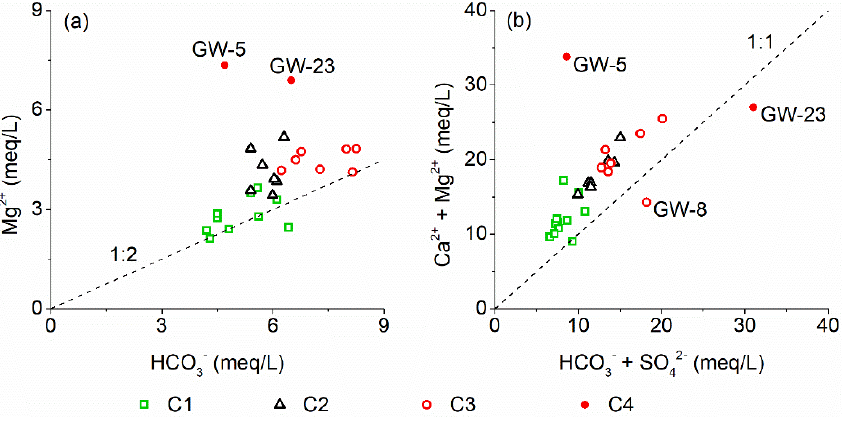
Figure 6. Relationship between Mg 2+ and HCO 3 − , Ca 2+ + Mg 2+ and HCO 3 − + SO 42 − in groundwater in the study area.